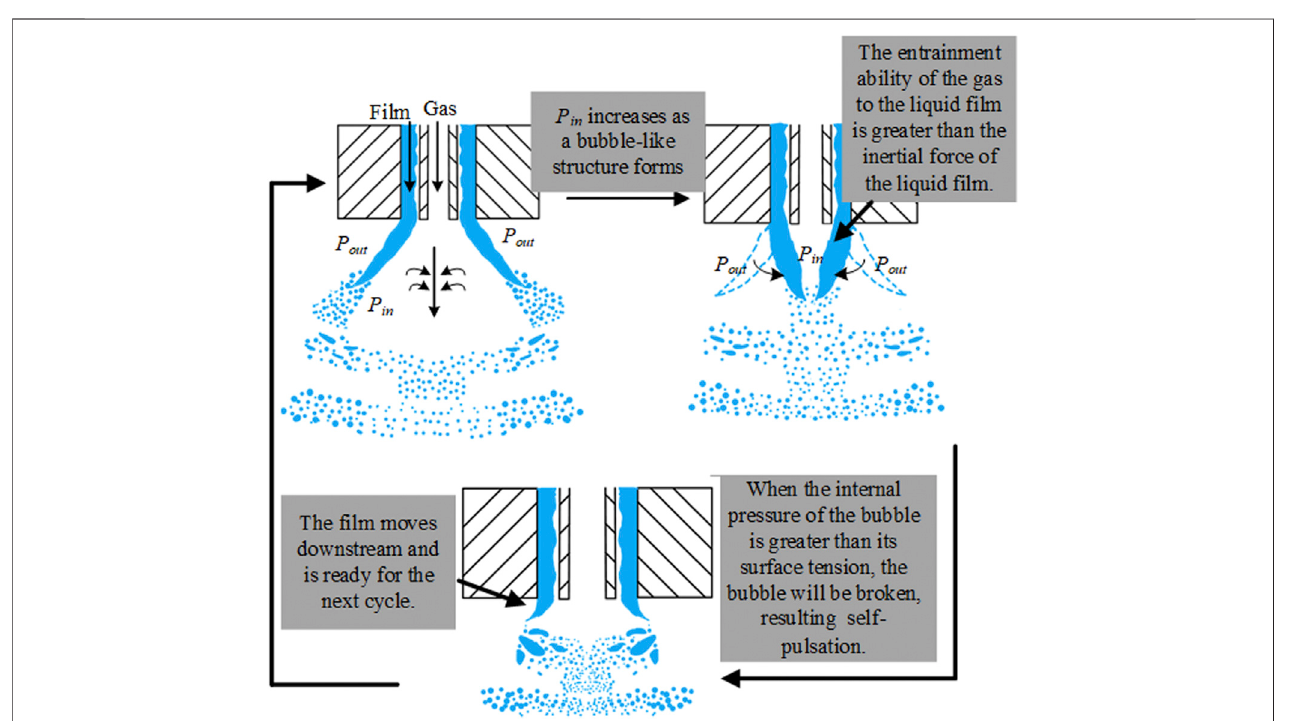
FIGURE 12 | Spray self-pulsation mechanism without